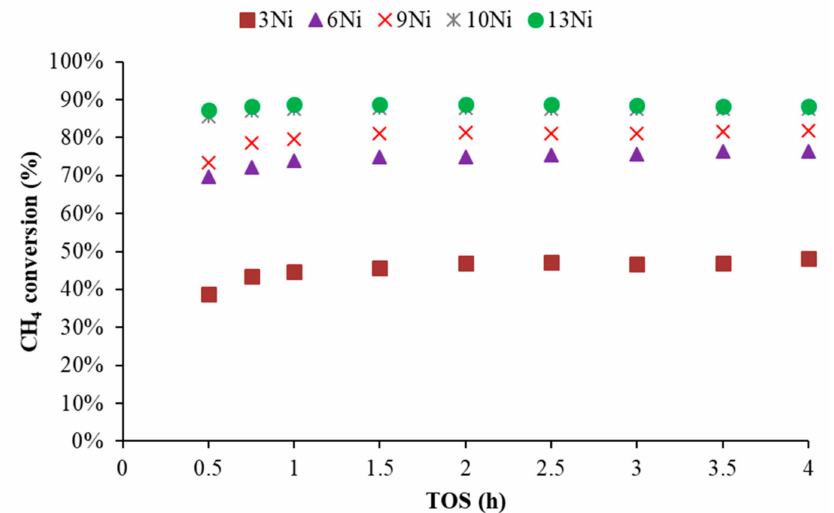
Figure 1. Effect of Ni content: evolution of CH 4 conversion as a function of time (CO 2 /CH 4 = 1.25, 842 ◦ C, Catalysts are calcined at 900 ◦ C for 12 h).